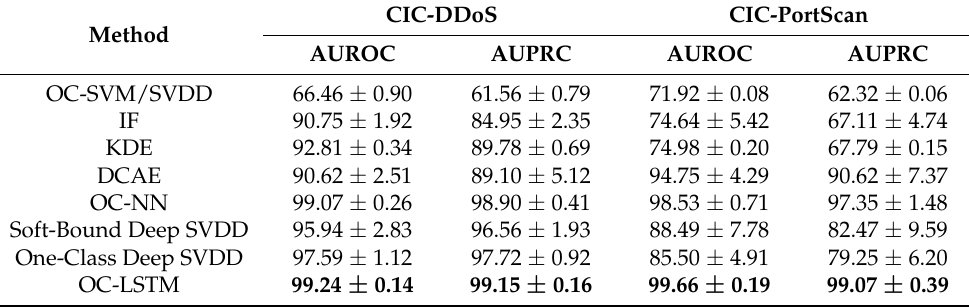
Table 4. Average AUROC and AUPRC as percentages with StdDevs per method on